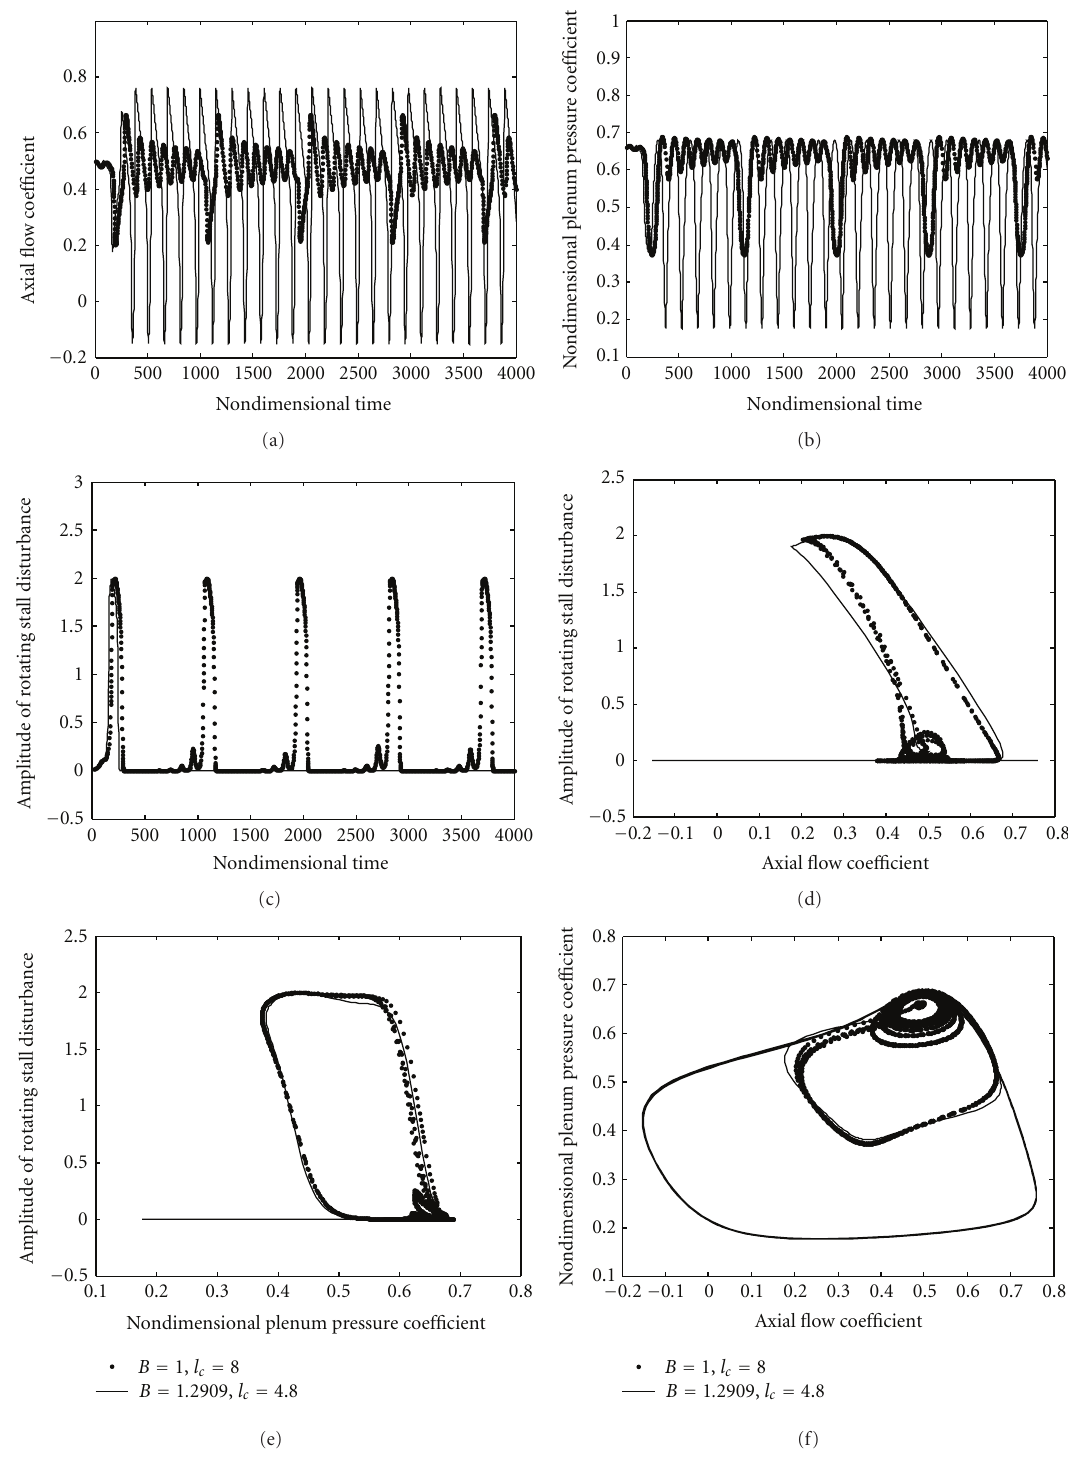
Figure 9: E ff ect of decrease in compressor e ff ective length: variation of nondimensional flow properties (a), (b), and (c) with time. (a) Axial flow coe ffi cient, (b) plenum pressure rise coe ffi cient, and (c) disturbance amplitude of rotating stall. (d) Variation of axial flow coe ffi cient with disturbance amplitude of rotating stall. (e) Variation of plenum pressure rise coe ffi cient with disturbance amplitude of rotating stall. (f) Limit cycle oscillation: axial flow coe ffi cient versus plenum pressure rise coe ffi